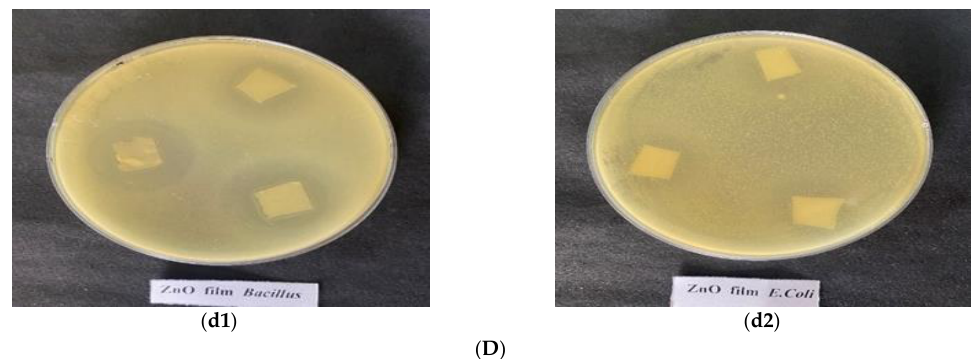
Figure 7. ( A ) Control slurry: ( a1 ) composite slurry; ( a2 ) composite with PVA (antibacterial activity against E. coli and B. cereus ) ( B ) ZnO nanocomposite Slurry (antibacterial activity against E. coli and B. cereus ) ( C ) Control film: ( c1 ) composite film; ( c2 ) composite with PVA film (antibacterial activity against E. coli and B. cereus ) ( D ): Zno film: ( d1 ) Bacillus cereus ; ( d2 ) E. coli. (antibacterial activity against tested organisms ).